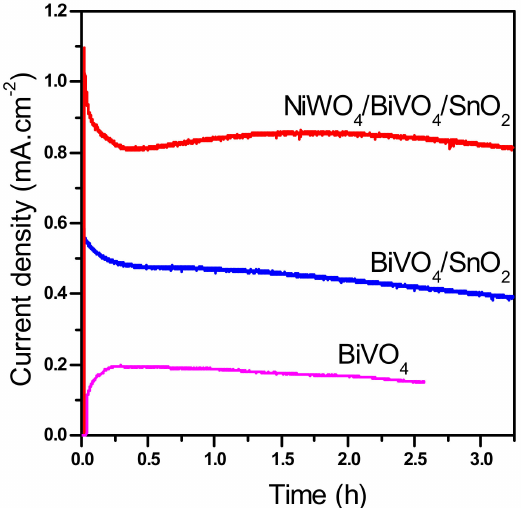
Figure 8. Long-term stability investigation. J-t curves for long-standing photostability of triple-layered NiWO 4 / BiVO 4 / SnO 2 photoanodes ( red ), BiVO 4 / SnO 2 photoanode ( blue ), and bare BiVO 4 ( magenta ) evaluated in phosphate bu ff er (0.1 M, pH 7.5) at 1.23 V RHE under illumination conditions for all